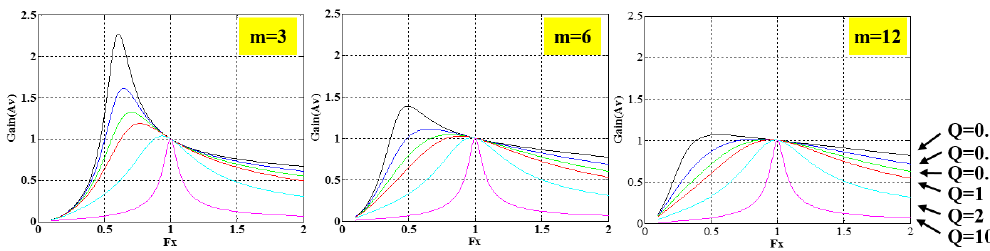
Figure 9. Comparison of the voltage gain under different m and Q factors.